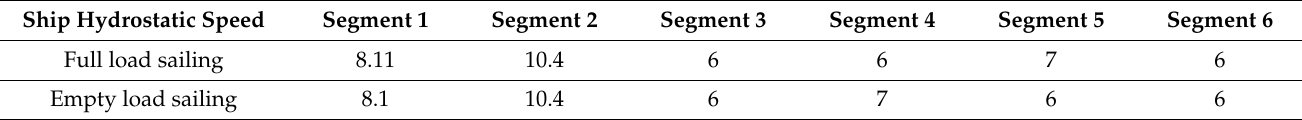
Table 7. Sailing plan of the ship in one whole